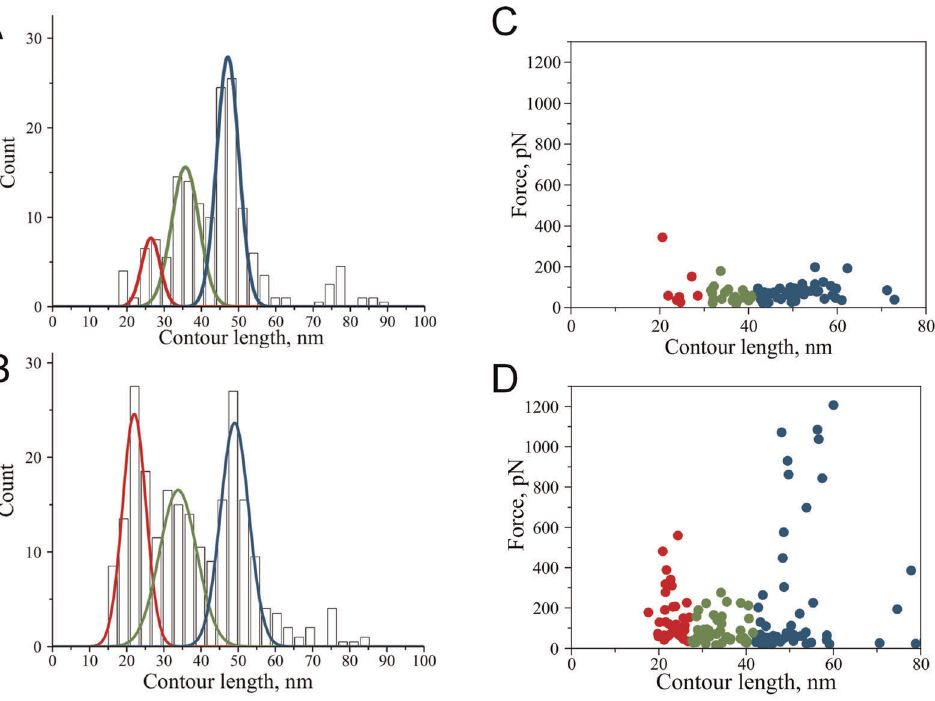
Figure 4. Statistical histograms of measured contour length values. A) Wild type, B) A30P mutant; the histograms were fit with Gaussian functions resulting in the following values of distribution maxima: 26 nm, 36 nm, 47 nm for WT and 22 nm, 34 nm, 49 nm for A30P mutant. Rupture force versus contour length plots C) Wild type, D) A30P mutant.